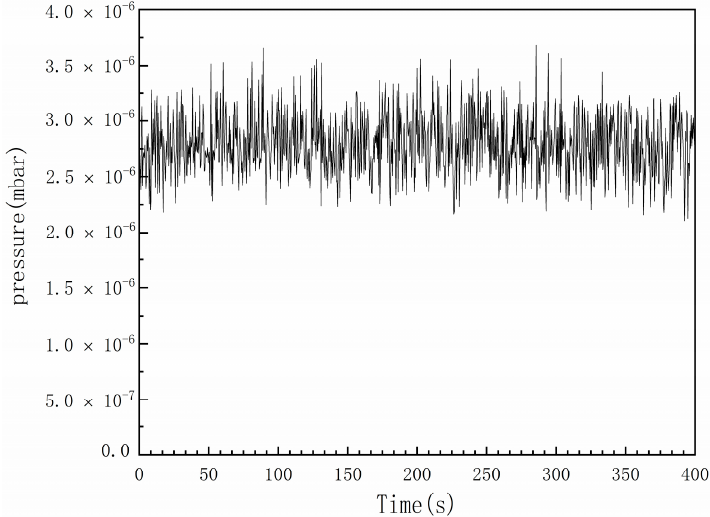
Figure 5. The change in the average pressure of the drift-pipe area of the vacuum chamber over time during the 400 s long-pulse.